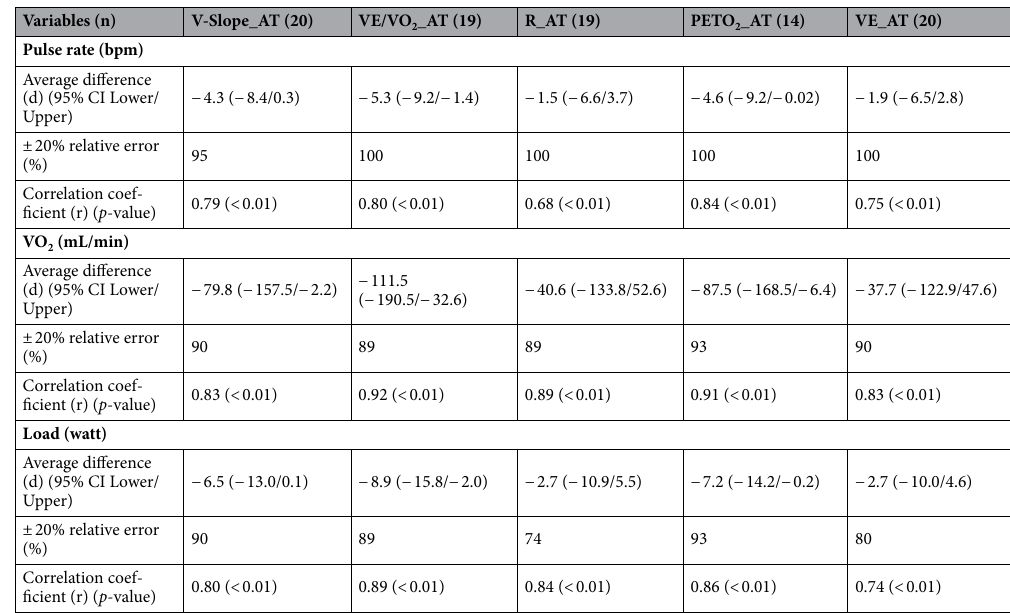
Table 3. Consistency, compatibility, and correlation of ST and AT. Bpm beats per minute, VO 2 oxygen consumption, V-Slope V-Slope,